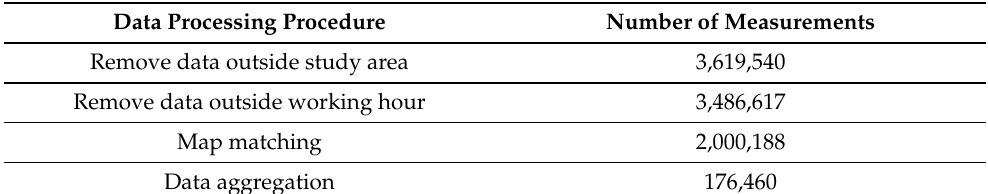
Table 1. The number of NO 2 measurements after each data processing step.